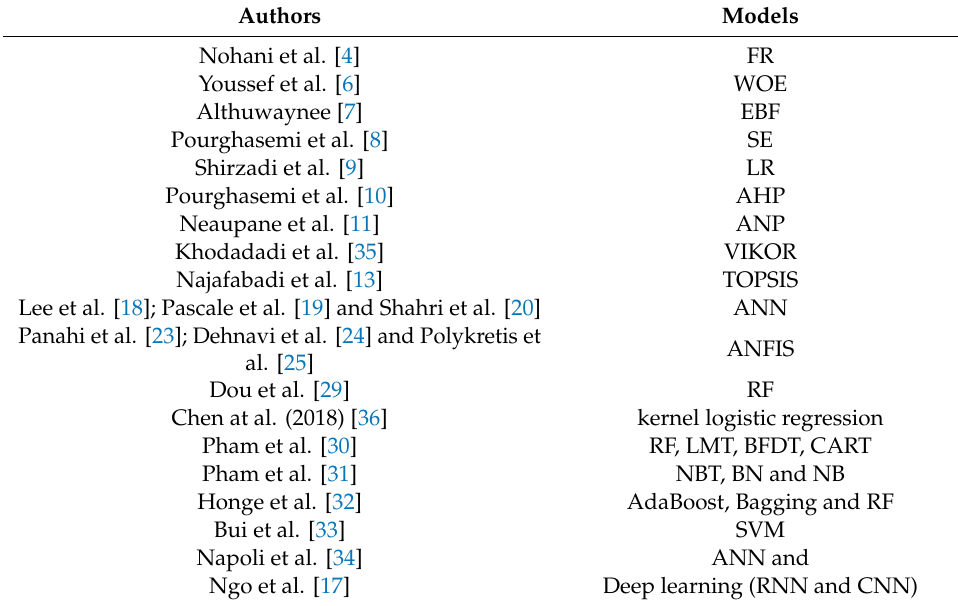
Table 1. Summarize of the literature